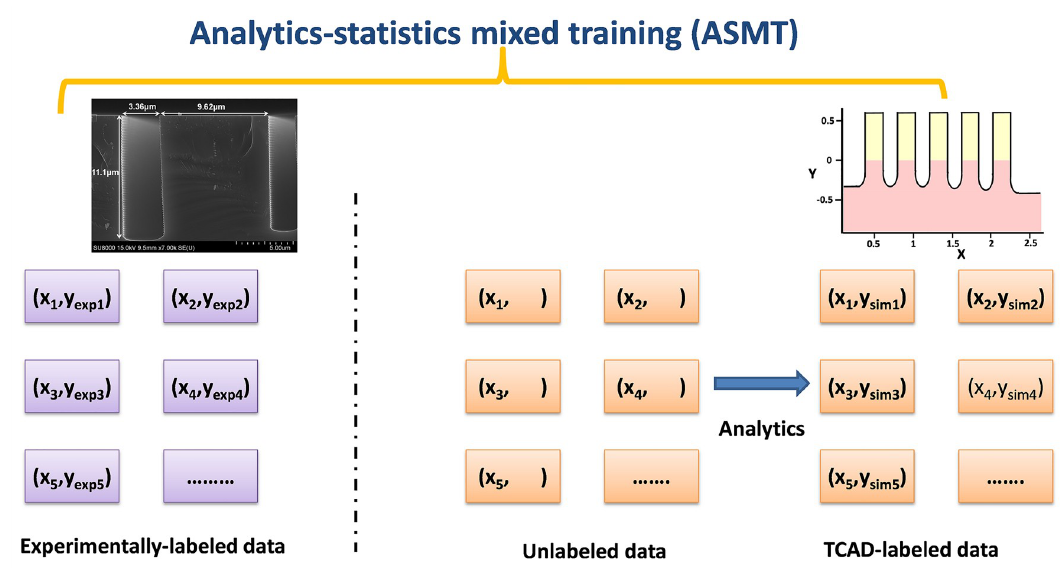
Fig 2. TCAD-labeled analytics-statistics mixed training (ASMT) uses the experimentally labeled and analytically labeled data in conjunction with the TCAD simulations. The model fits the into the SSL framework well since the unlabeled data can be labeled in SSL using the analytical models and then be fed into supervised learning models. The analytics-labeled data can also serve as the initial guess in the expectation-maximization algorithm under SSL or the selection criteria in self-training.